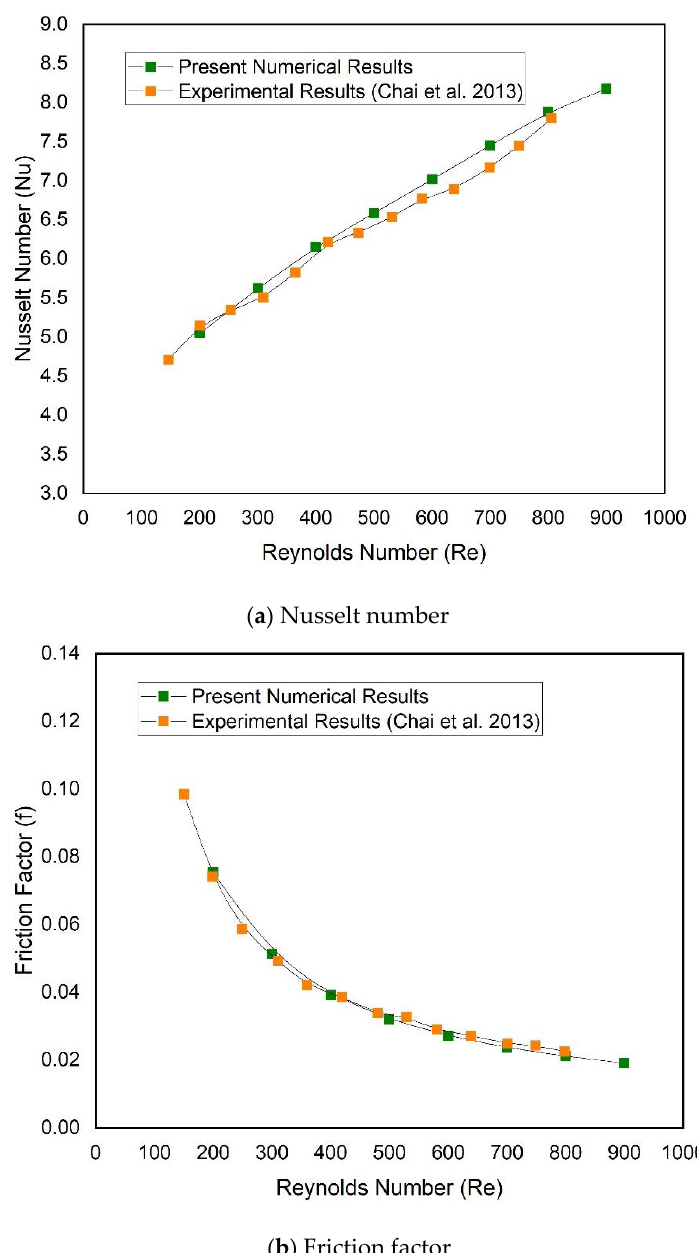
Figure 4. Comparison between numerical experimental results data for ( a ) Nusselt numbers and ( b ) friction factors [28] .